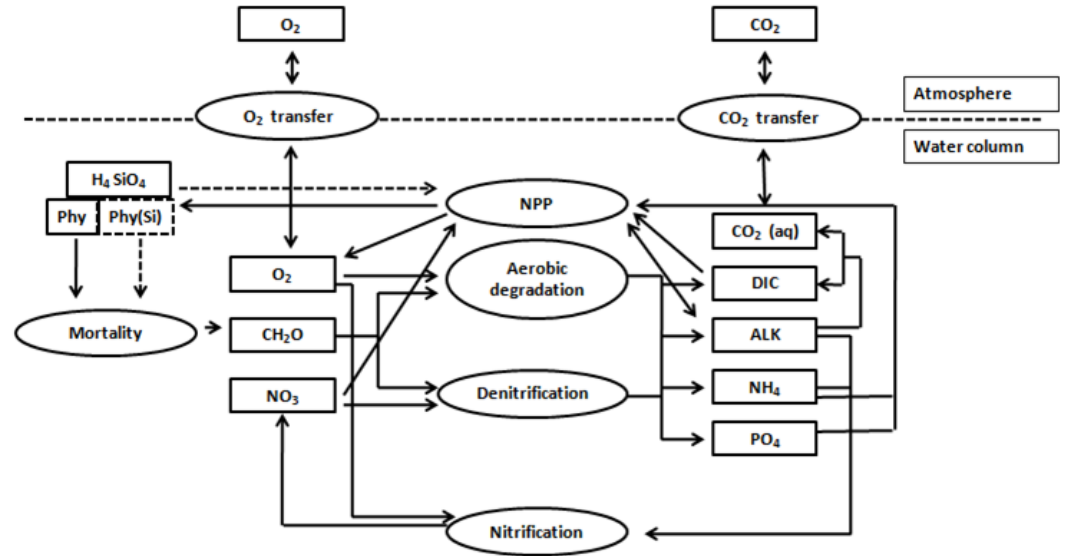
Figure 4. Conceptual scheme of the biogeochemical module of C-GEM used in this study. State variables and processes are represented by boxes and ovals, respectively. Modified from Volta et al.